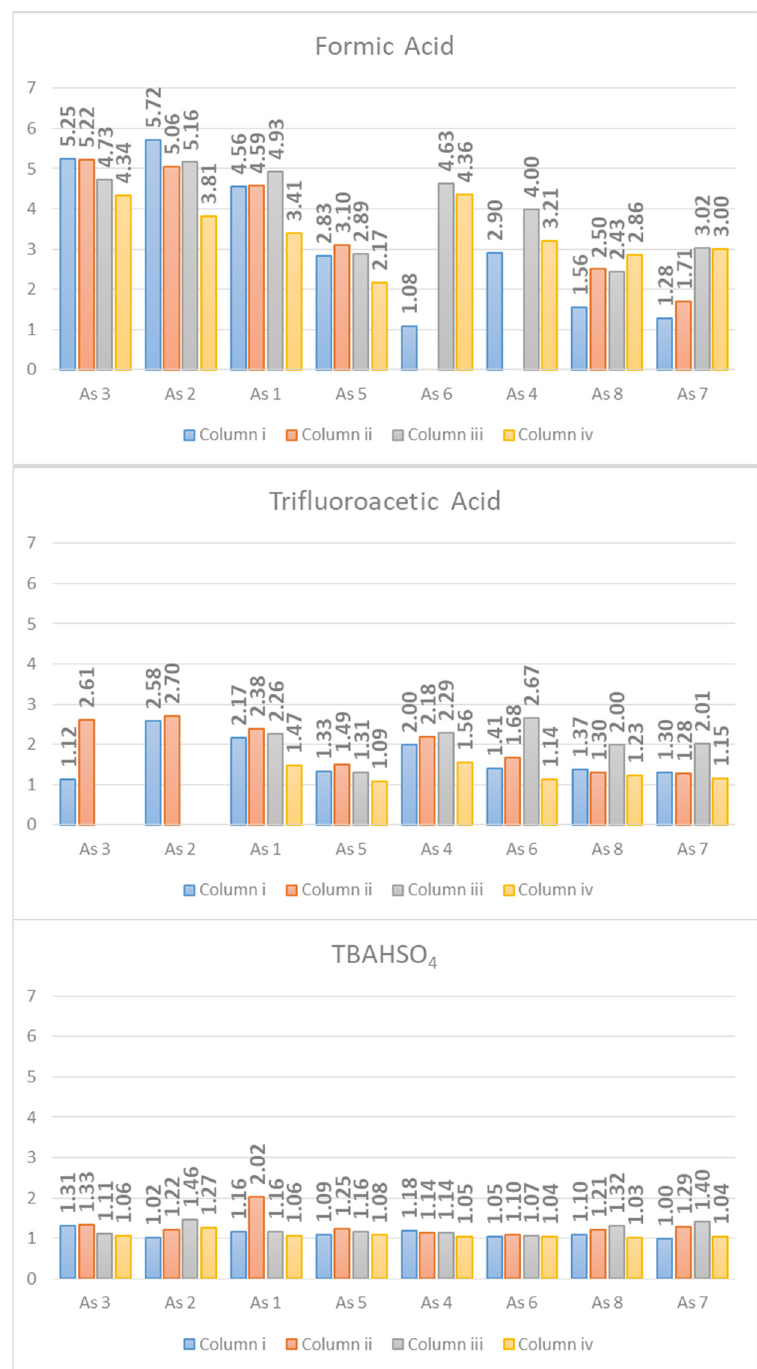
Figure 4. Asymmetry values ( As ).